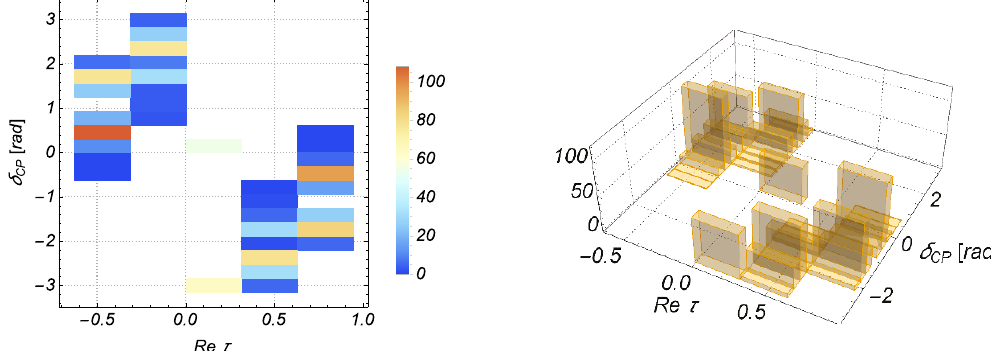
Figure 7 . Distributions of the CP-violating phase δ CP vs. real part of complex structure modulus Re τ for Im τ = 1 . 7 in Pattern